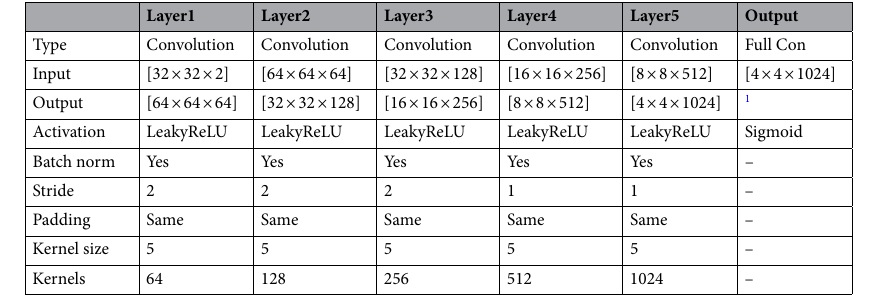
Table 2. Discriminator architecture: minibatch size: 32; optimizer: Adam (η = 0.0001, β1 = 0.5, β2 =